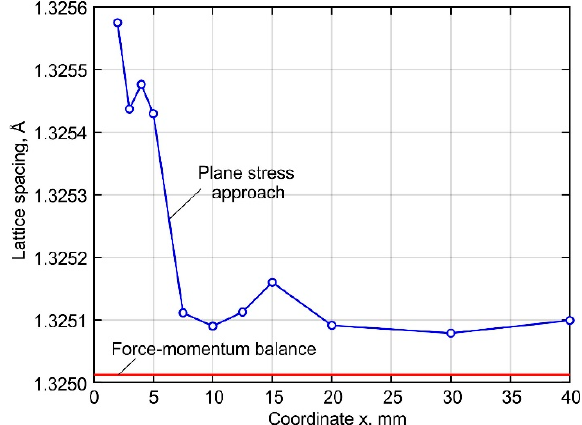
Figure 6. Distribution of stress-free d o interplanar distance.